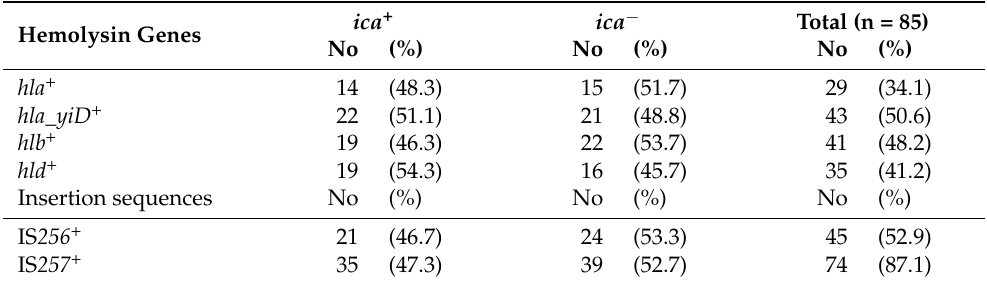
Table 5. Comparison of the prevalence rates of the genes involved in the hemolysin production, ica ADBC operon and insertion